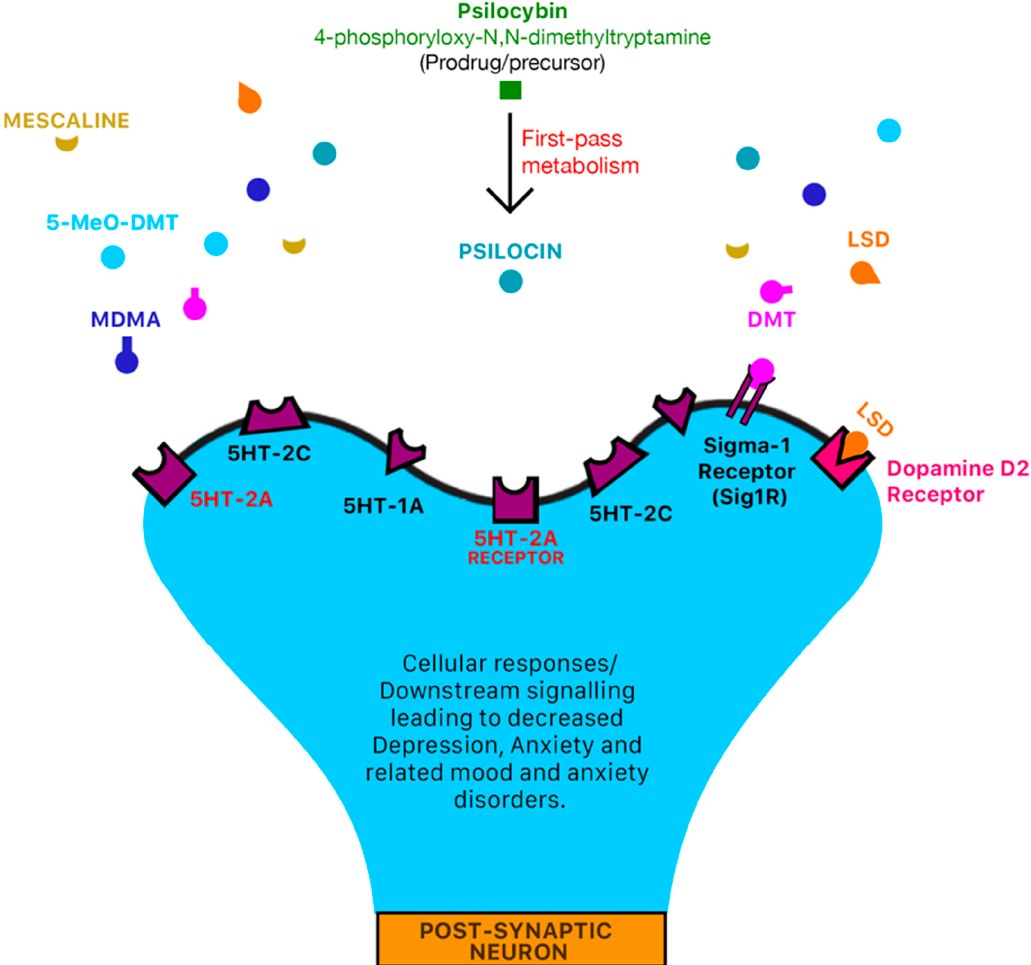
Figure 1. Mechanism of action of classic serotonergic drugs. 5-HT serotonin receptors are densely located in areas of the brain that are responsible for mediation of mood and anxiety disorders such as the pre-frontal cortex [18,24]. Classic serotonergic psychedelic drugs such as LSD, DMT, 5-MeO-DMT, mescaline, psilocybin and MDMA all have an affinity for serotonergic 5-HT receptors [17] which may mediate the psychotomimetic and pharmacological effects of psychedelic drugs. LSD may also interact with dopamine D2 receptors and trace-amine associated receptors (TAARs) to produce psychotomimetic and pharmacological effects [22]. DMT also interacts agonistically with the sigma-1 receptor (Sig1R) [22,23] and trace-amine associated receptors (TAARs) to produce anti-inflammatory and anti-oxidant effects [22]. In pre-clinical animal models, trace-amine associated receptors such as TAAR1 have been identified as a novel target for metabolic disorders, drug addiction, neurological and psychiatric diseases such as depression and schizophrenia [25–28].